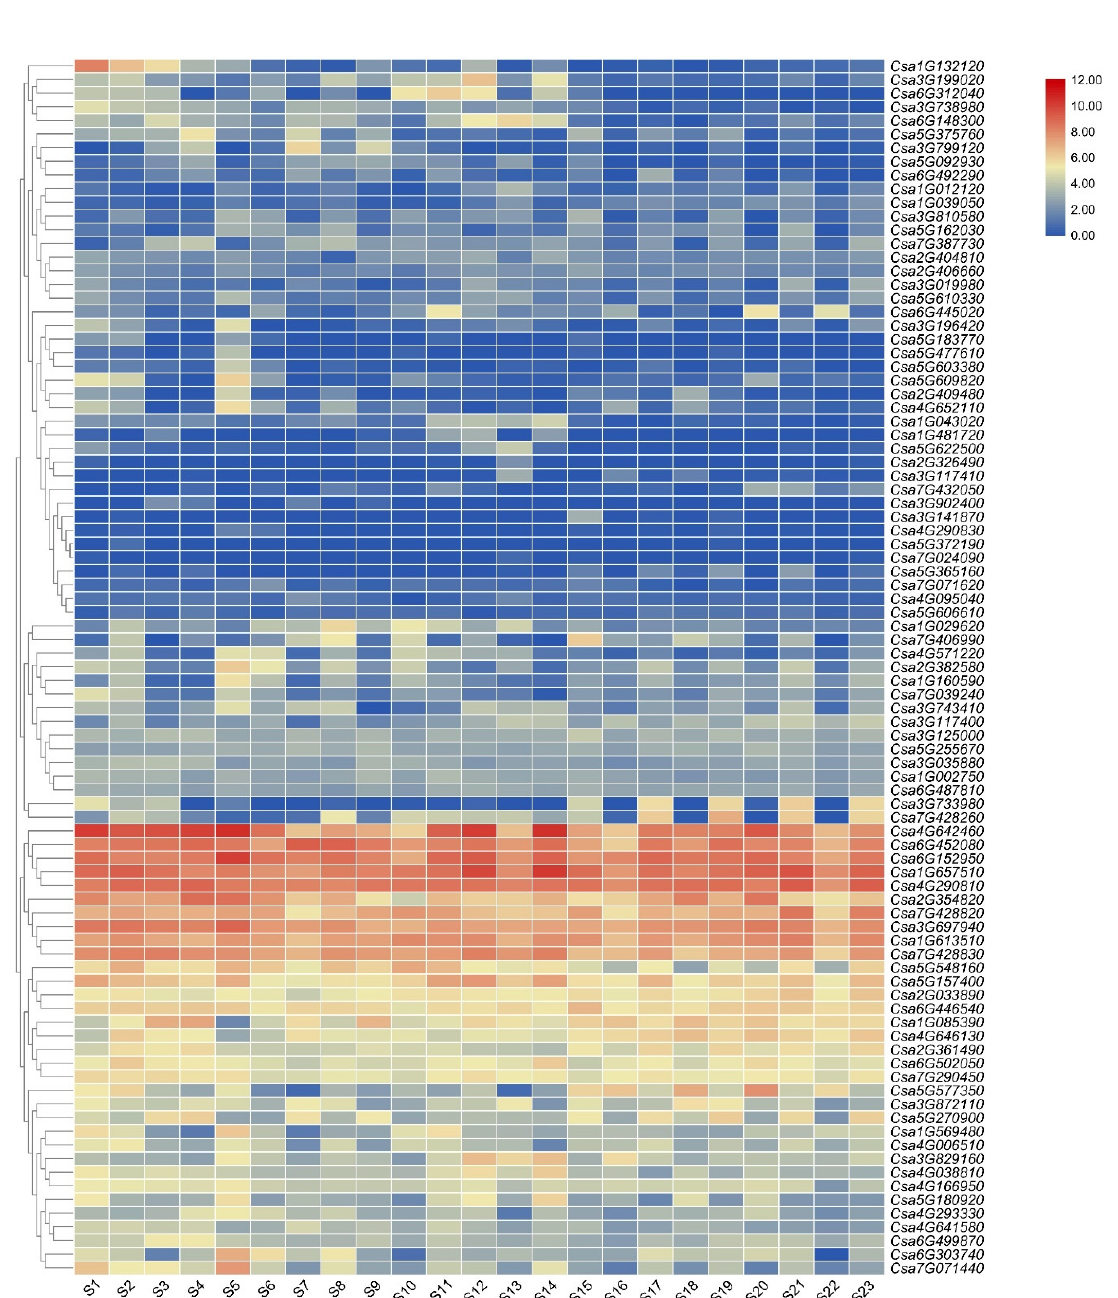
Figure 5. A heatmap showing the expression of C2H2-ZFP genes in different tissues. The following abbreviations are used: S1, roots of 4-week-old seedlings; S2, hypocotyl of 4-week-old seedlings; S3, cotyledon of 4-week-old seedlings; S4, true leaf of 4-week-old seedlings; S5, root; S6, stem; S7, young leaf (the second node from the top of cucumber plants); S8, petiole of young leaf; S9, old leaf (the fifth node from the top of cucumber plants); S10, petiole of old leaf; S11, tendril; S12, female flower; S13, male flower bud; S14, male flower; S15, unfertilized ovary; S16, peel of unfertilized ovary; S17, flesh of unfertilized ovary; S18, peel of 1-week-old fruit; S19, flesh of 1-week-old fruit; S20, peel of 2-week-old fruit; S21, flesh of 2-week-old fruit; S22, peel of 3-week-old fruit; S23, flesh of 3-week-old fruit. [45]. Genes highly expressed in tissues are colored red and genes not expressed in tissues are colored blue.